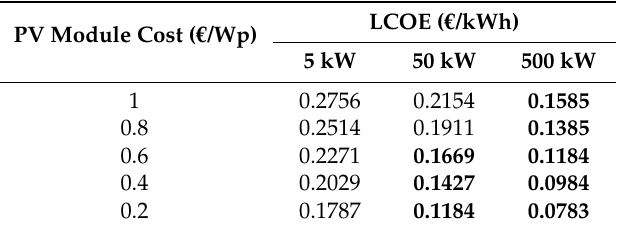
Table 15. Comparison of the LCOE based on the Monte Carlo method for all the cases.